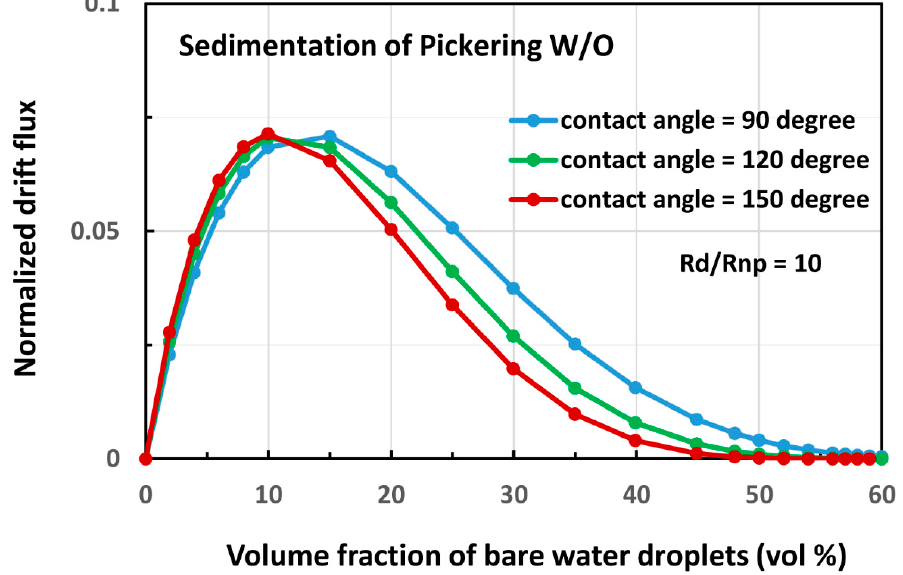
Figure 19. Effect of contact angle on normalized drift flux of Pickering W/O emulsions. Figure 19. E ff ect of contact angle on normalized drift flux of Pickering W / O